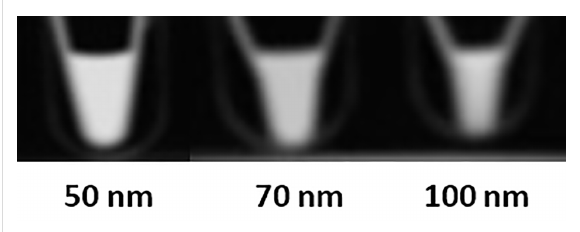
Figure 6: CT images of Au-CPMV particles of different sizes suspended in DD water at, the gold concentration is 200 μ g of gold suspended in 200 μ l aqueous solution for each sample. The average CT values from three scans for each sample were 183 HU, 133 HU, and 115 HU for the 50 nm, 70 nm, and 100 nm,